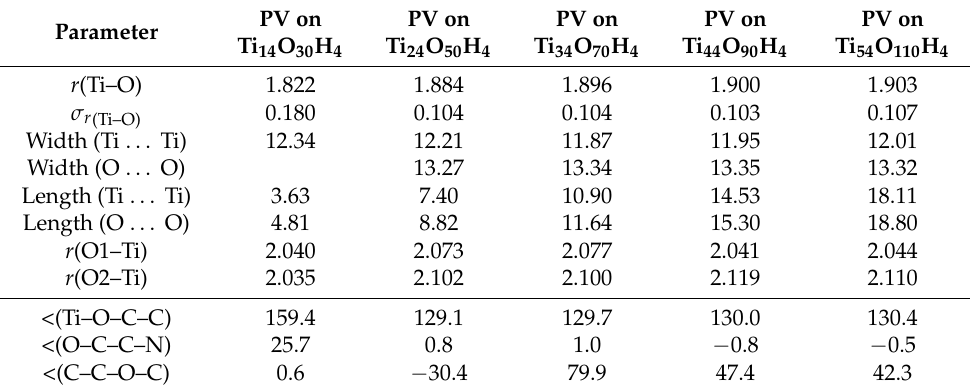
Table 7. The structural parameters of the model system consisting of the Ti n O 2 n +2 H 4 clusters ( n = 14, 24) with an adsorbed penicillin V molecule, obtained after geometry optimization by DFT/B3LYP/3-21G(d) in vacuum. Geometrical parameters describing the adsorption configurations: bond lengths (in Å) and torsion angles (in deg.) of the PV relative to the Ti–O bond, to the carboxyl group, and of the rest of the PV with respect to the phenyl group 1 . PV Parameter